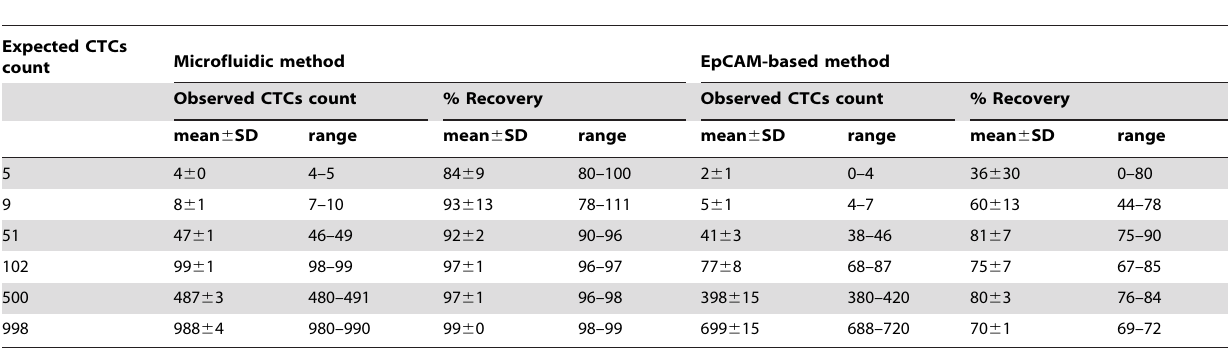
Table 1. Comparison of two method accuracy measured by recovery of HT-29 cells spiked into 5 mL blood of healthy donors.